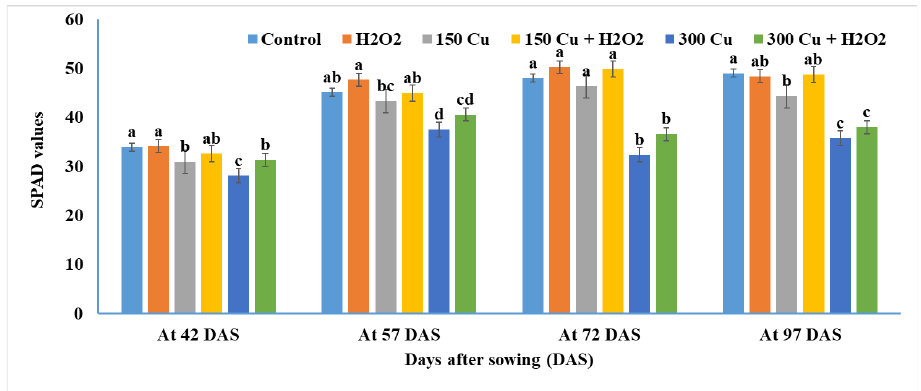
Figure 4. Effect of hydrogen peroxide on total chlorophyll content (SPAD) at 42, 57, 72, and 97 DAS of wheat grown in contaminated sandy soil. Means followed by the same letter at each sampling date are not significantly different according to the least significant differences (LSD) test ( p ≤ 0.05). Error bars are ± Standard Error